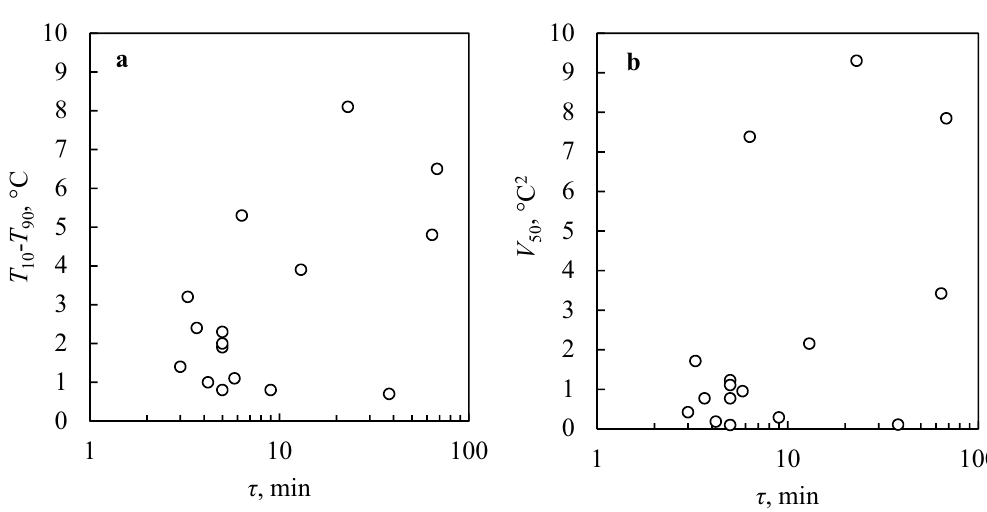
Figure 3. Width of the nucleation temperature distribution ( a : T 10 - T 90 , in °C, b : V 50 , in °C 2 ) versus the residence time above 0 °C ( τ , in logarithmic scale). All these experiments were performed at T th = 20 °C (numbers X– XXIV in Table 1). The omnibus test suggests the presence of a significant correlation between τ and both T 10 - T 90 (F-value 14.4, degrees of freedom 12, p-value 0.02) and V 50 (F-value 44.4, degrees of freedom 12, p-value 0.005). The number of degrees of freedom represents the number of independent subgroups in the considered dataset. The F-value is calculated by dividing the variance of the subgroups’ means by the mean of the within-subgroup variances. The p-value, instead, indicates the probability of obtaining results at least as extreme as those observed without any correlation between the input variables (in this case, τ and T 10 - T 90 or τ and V 50 ). Large F-values and small p-values are indicative of the